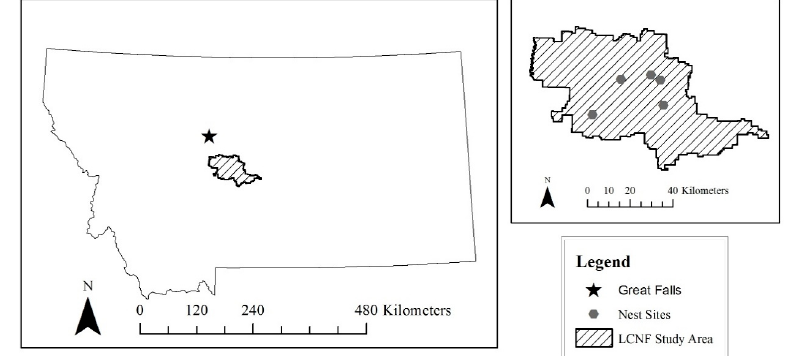
Figure 2. Little Belt Mountains, part of the Jefferson Division of the Lewis and Clark Naitonal Forest, lcoated southeast of Great Falls in central Montana. Nest sites are approximated locations. The Little Belt Mountains are a segment of the Jefferson Division of the Helena-Lewis and Clark National Forest. Located in central Montana southeast of the city of Great Falls, the Little Belt Mountains encompass approximately 40,000 hectares of national forest land and additional privately- owned land. Considered an island range, the Little Belts are a section of the northern Rocky Mountains. Average elevation for the range is around 2500 m with the highest point at 2800 m. The forest is composed primarily of Douglas fir ( Pseudotsuga menziesii ) and lodgepole pine ( Pinua contorta ), but other associated species include white spruce ( Picea glauca ), Engelmann spruce ( Picea engelmannii ), and subalpine fir ( Abies lasiocarpa ) [25]. The US Forest service manges activities in this area including timber harvest, fire suppression, and recreation. Five active nest sites were identified in the Little Belts, two sites near Highway 89 and Monarch and three sites near southwest of Highway 87 in the Judith Basin. No human persecution of goshawks occurred in Montana. 3. Methods To examine the differences in nesting defense behavioral between goshawks in Finland and Montana, three experimental conditions were presented at each occupied nest in the sample areas. All trials were conducted consecutively on the same day with rest intervals of at least 15 min between trials to allow the birds to return to the nest, check on the chicks, and recover from stress. The rest period varied, depending on the degree of response from the birds, with more aggressive responses leading to a longer rest period. Trial periods were twenty minutes long. Time of testing was variable due to 23 h of daylight in Finland during the summer, but testing always occurred during daylight hours (between 6 AM and 5 PM for Montana). Trials took place in Finland from 23–25 May 2016 and from 13 June–6 July 2016 in Montana. We recorded ambient data such as temperature, weather conditions, starting/ending times of each trial, response type, time, and sex of the bird in a field notebook. The first condition was a natural predator, the Eurasian Eagle Owl ( Bubo bubo ) in Finland and the Great Horned Owl ( Bubo virginianus) in Montana. These owls are both predators of Goshawk at nest sites [26–29]. Decoys were prepared from study skins of each species. The skins were stuffed to mimic a live owl, and the basic components from a Lego ® remote control set were used to construct a frame to fit the head in order to make it move to the left and right approximately 180°. The owl decoys were set up on a five-foot stick collected from the forest floor at the sampling locations. A predator call box (ICOtec ® GC300 Electronic Predator Call, Cabalas, Kearney, NE, USA) with a recorded owl call was placed at the base of the decoy, and calls were played every 2–5 min until there was a response from the goshawk.